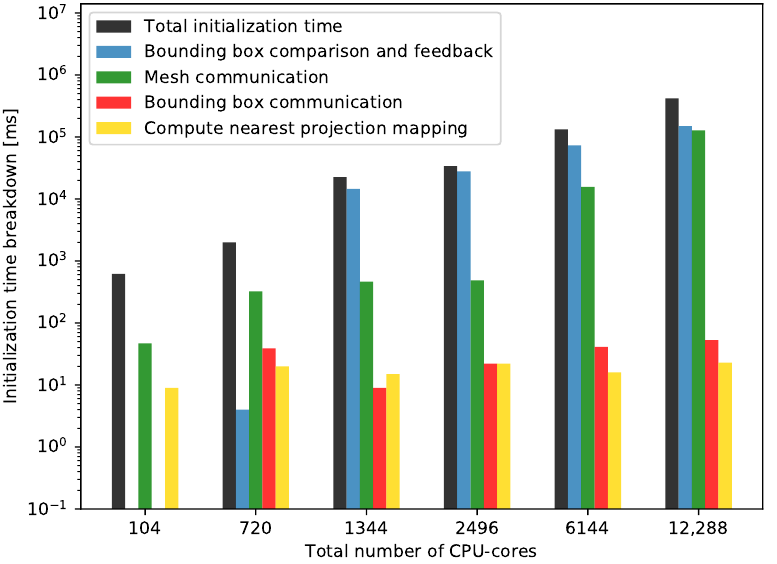
Figure 15. Weak scalability measurements: Initialization time breakdown for the two-level initializa- tion scheme. Only algorithmic parts with significant contributions to the initialization runtime are depicted: 1—Bounding box comparison and feedback (Figure 1 levels IV and V). 2—Mesh communi- cation (Figure 2 levels II). 3—Bounding box communication (Figure 1 levels II and III). 4—Compute nearest projection mapping (Figure 2 level II). The core distribution and the mesh information are given in Table